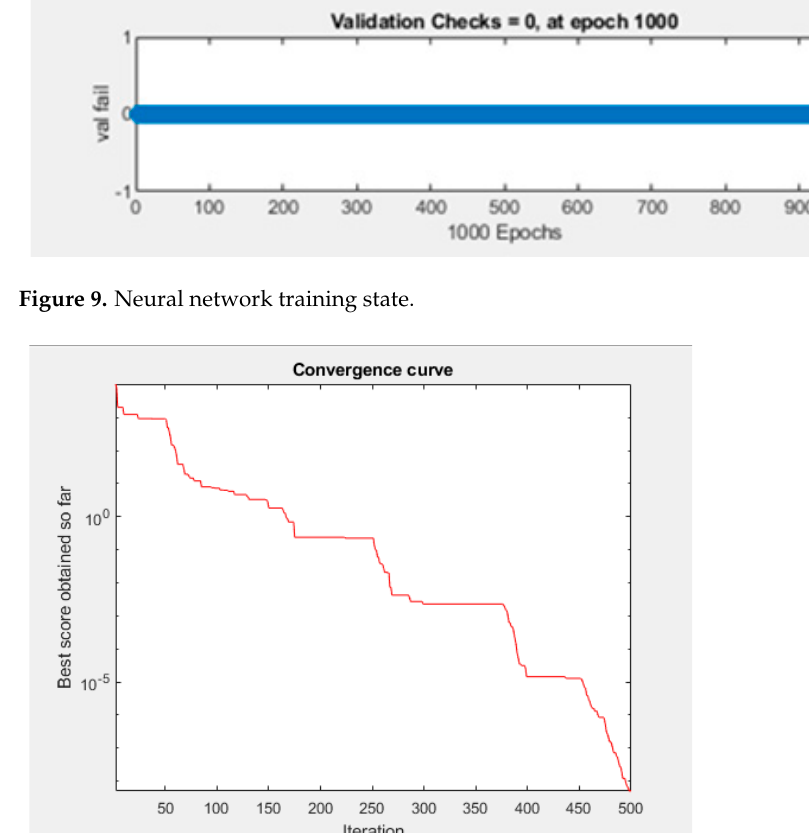
Figure 9. Neural network training state